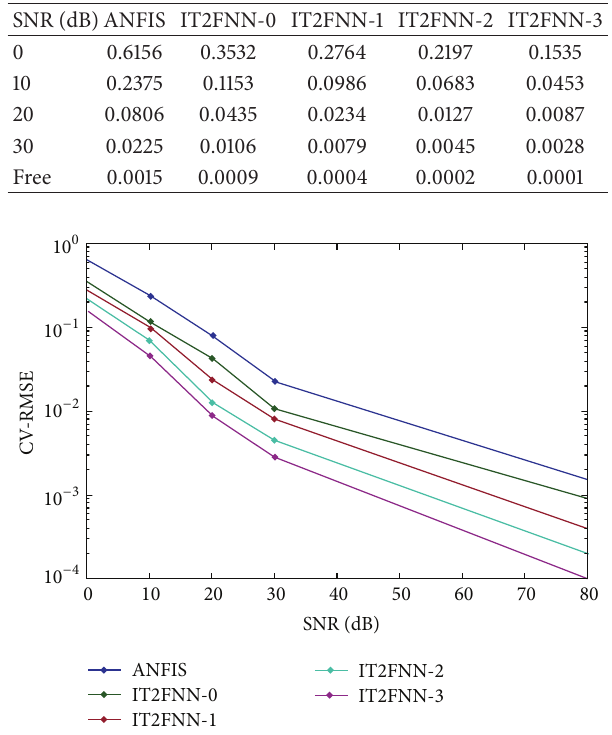
Figure 7: RMSE (CHK) values of ANFIS and IT2FNN using 10-fold cross-validation for identifying nonlinearity in Experiment